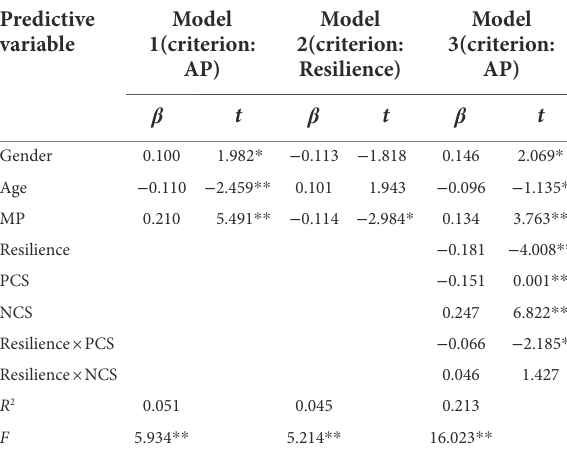
TABLE 3 The model of mediating effect with